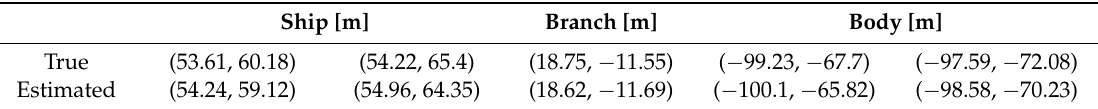
Table 11. The landmark point positions of the ship, branch and body estimated by the AEKF and the true ones detected by the maximum entropy